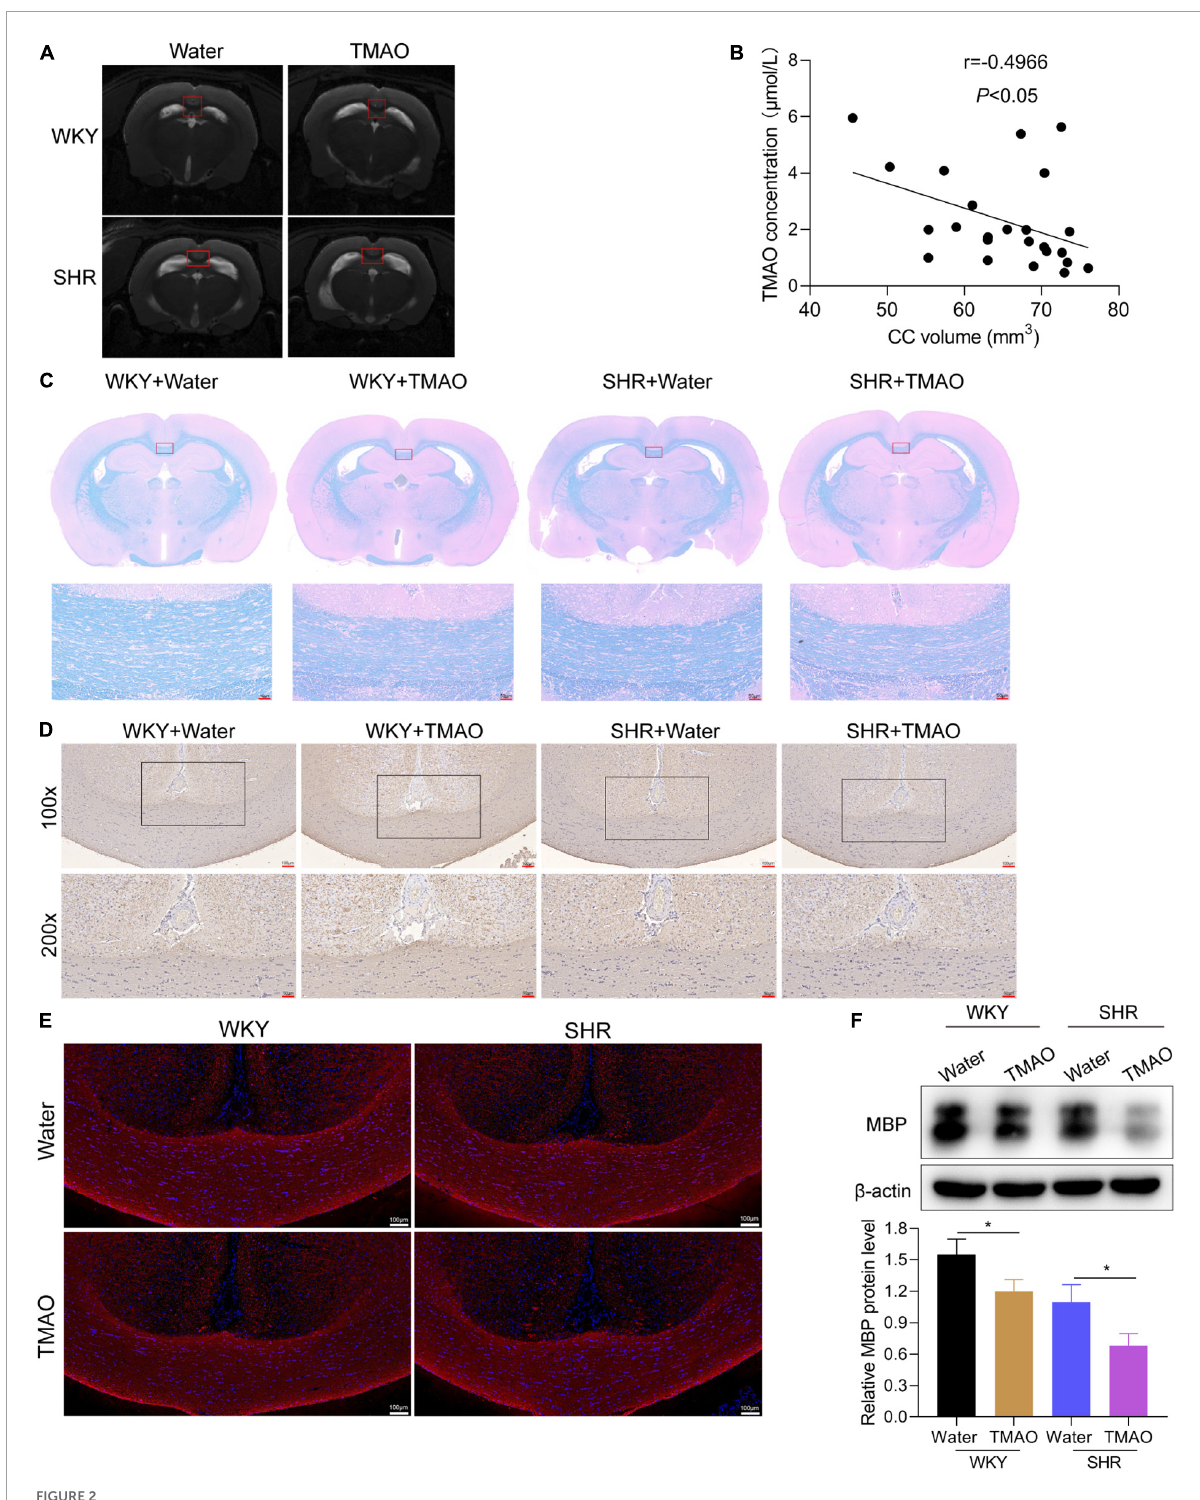
FIGURE2 TMAO promoted demyelination of white matter in hypertensive rats. (A) Images of T2-weighted MRI in SHR and WKY rats treated with TMAO or water. (B) The association between TMAO levels and corpus callosum volumes was analyzed using Spearman correlation analysis. (C) Luxol Fast Blue staining was used to evaluate myelin change. Scale bar: 50 µ m. (D) MBP expressions were measured by IHC staining. Scale bar: upper, 100 µ m; lower, 50 µ m. (E) Immunofluorescence assay for MBP (red) staining in corpus callosum tissues. Scale bar: 100 µ m (F) MBP expressions were measured by western blot. The data were expressed as mean ± SD of three independent experiments. * P <